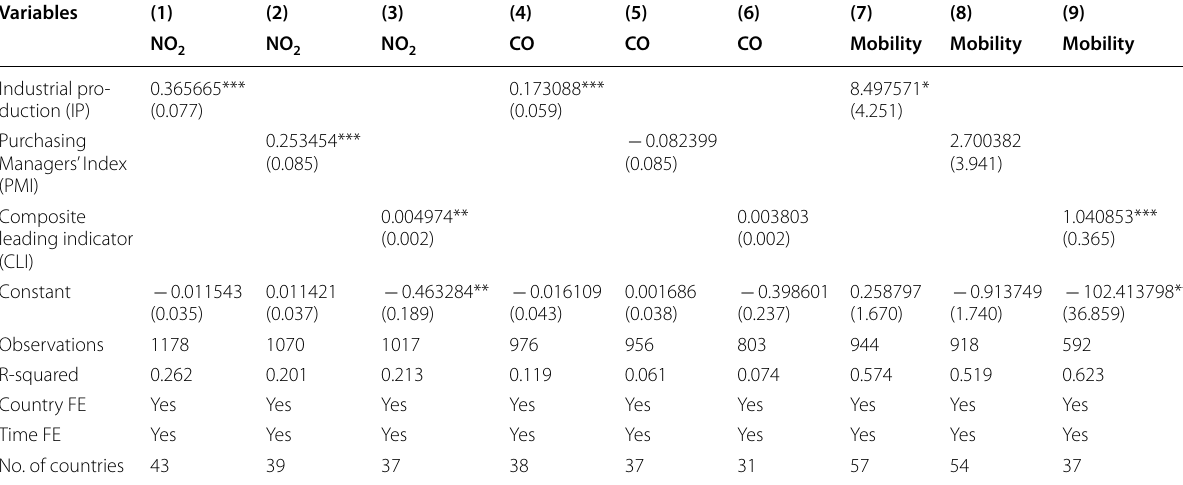
Standard error clustered at the country level. Robust standard errors in parentheses ***, **, and * represent statistically significant at 1, 5, and 10%, respectively